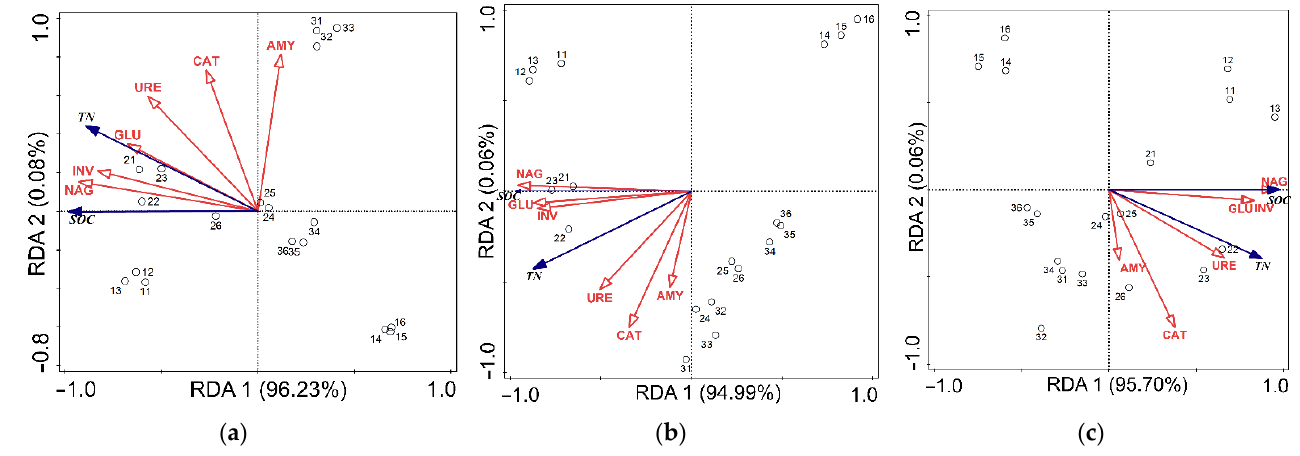
Figure 4. Redundancy analysis between SOC, TN, and soil enzyme activities in soil aggregates: ( a ) macro-aggregates; ( b ) meso-aggregates; and ( c ) micro-aggregates. RDA 1 and RDA 2 refer to the first and second axis in RDA ordination diagram, and their explanations to variables are shown in the parentheses. The length of the arrow indicates the relative variance explained by that factor. Correlations between SOC, TN, and soil enzyme activities are represented by the length and angle of lines.